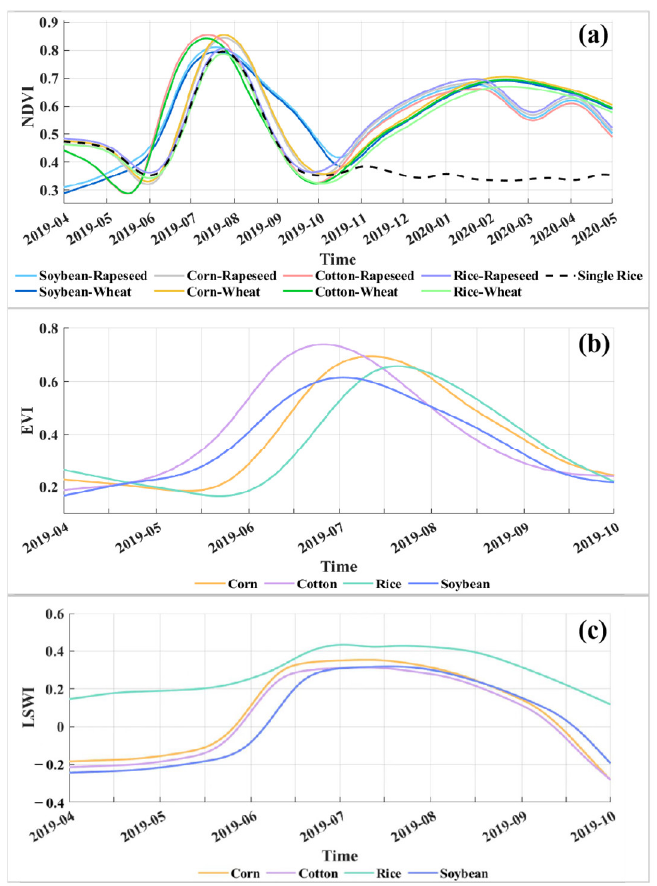
Figure 5. Temporal profile of VIs (NDVI, EVI, and LSWI) for planting pattern with ( a ) NDVI of all crop planting patterns, ( b ) EVI of summer crops in double cropping, and ( c ) LSWI of summer crops in double